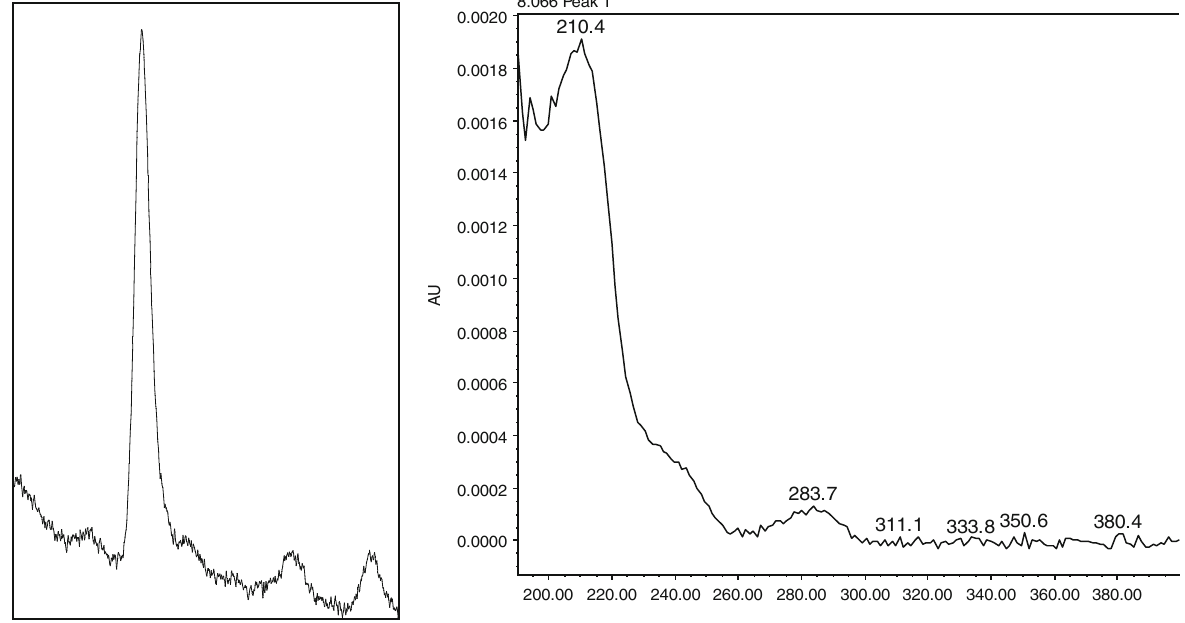
Fig. 2 Morphine peak and its UV spectrum at 0.001 mg/mL